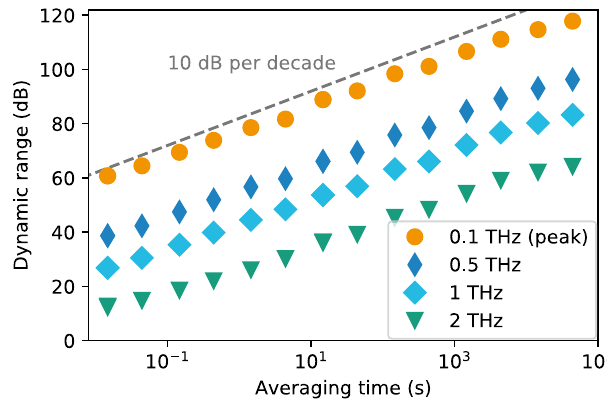
Fig. 5 Dynamic range as a function of averaging time for selected frequencies within the THz spectrum. Circles, diamonds, squares, and triangles correspond to frequencies of 0.1 (spectral maximum), 0.5, 1, and 2 THz. The dashed gray line indicates an increase of 10 dB per decade, as predicted by Eq. (20).